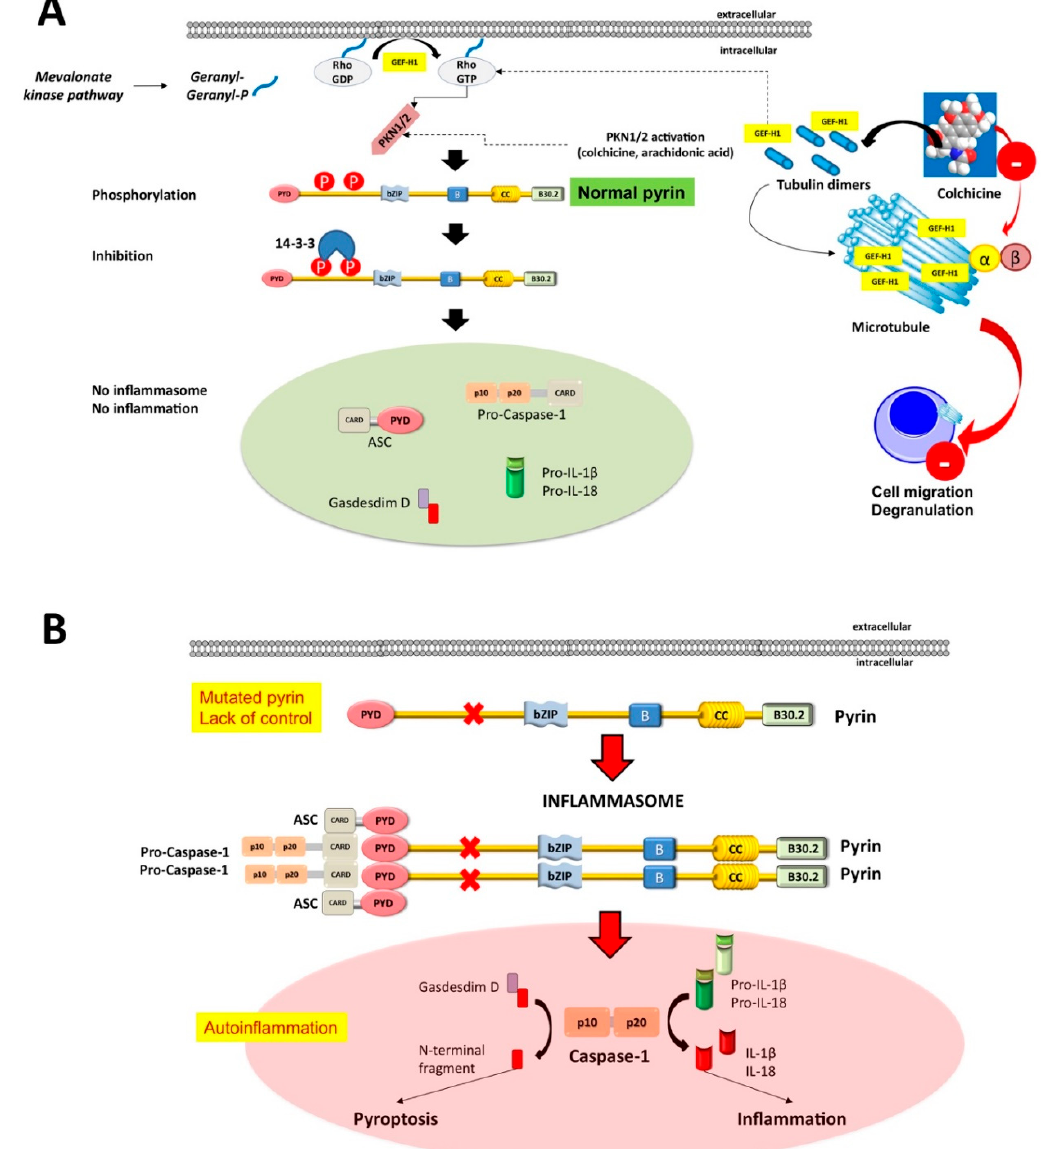
Figure 2. Mechanisms underlying the assembly of the pyrin inflammasome. ( A ) With a normally functioning pyrin (i.e., when pyrin is non-mutated), the mevalonate kinase pathway provides geranyl-geranyl phosphate and, together with release of GEF-H1 (increased by colchicine acting as the inhibitor of the microtubule polymerization), activates RhoA. PKN1 and PKN2 are effector kinases of RhoA mediating the phosphorylation of pyrin and binding to the inhibitory proteins 14-3-3. Inhibition of pyrin can increase with agents activating PKN1 / 2 or following the release of GEF-H1 (i.e., colchicine). ( B ) If the pyrin phosphorylation decreases, (i.e., in FMF patients lacking the control by pyrin / marenostrin caused by pathogenic MEFV variants), with low GEF-H1 or defective function of the MVK-pathway, the activation of PKN1 / 2 also decreases. This step results in pyrin inflammasome activation and release of mature IL-1 β and IL-18. The plasma membrane pore-forming N -terminal fragment of gasdermin D facilitates IL-1 β and IL-18 release. Appropriate stimuli can also lead to the assembly of the inflammasome. The first step is the PYD-PYD homotypic interaction of ASC resulting in oligomerization into ASC specks. Pro-caspase-1 is recruited because of CARD-CARD